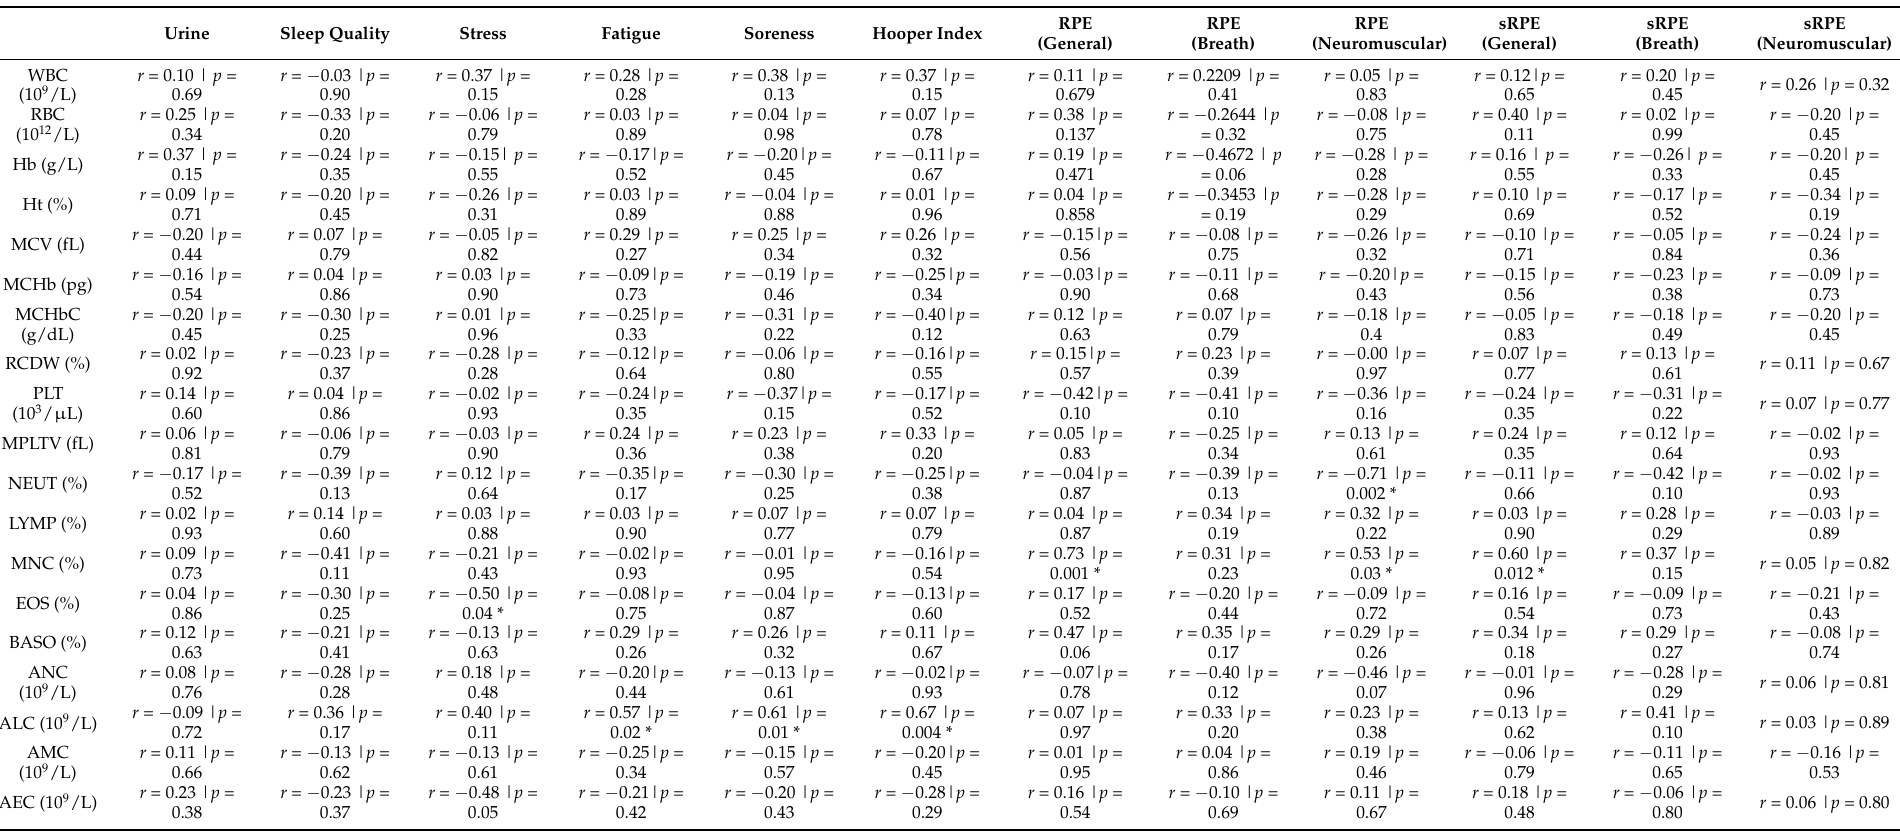
Table 4. Pearson correlations between percentage change of HP (before and after the pre-season) and percentage change of training loads (before and after the